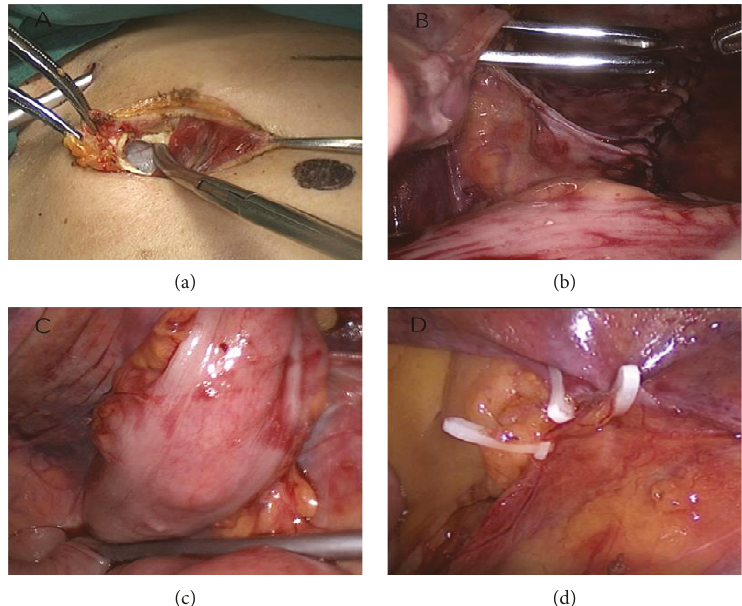
Figure 2: (a) A preplanned round skin incision of 3 cm in diameter should be made at the left McBurney point. (b) Break through the peritoneum to clamp the end sigmoid. (c) The end sigmoid was then grasped and exteriorized slowly through the oblique tunnel. (d) Close the space between the visceral peritoneum and stump